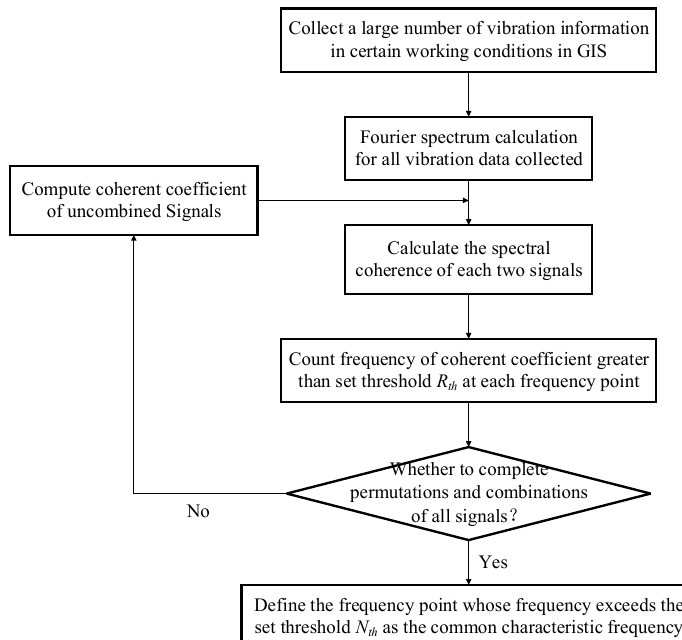
Figure 5. Feature extraction process.